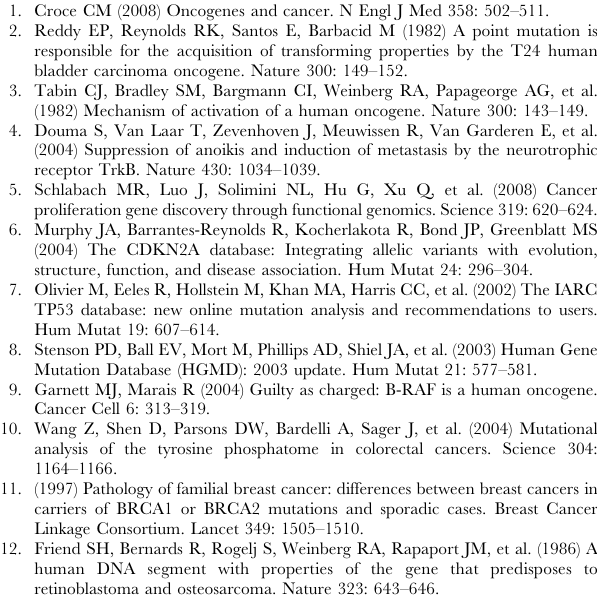
Table S1 Array CGH datasets.